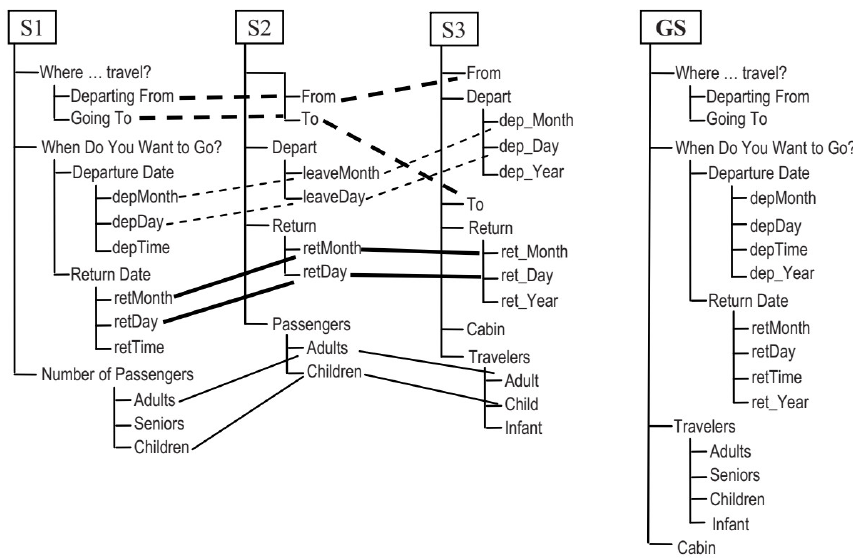
Figure 1. Three input query interfaces (S1, S2, and S3) and global query interface derived (GS) [2].